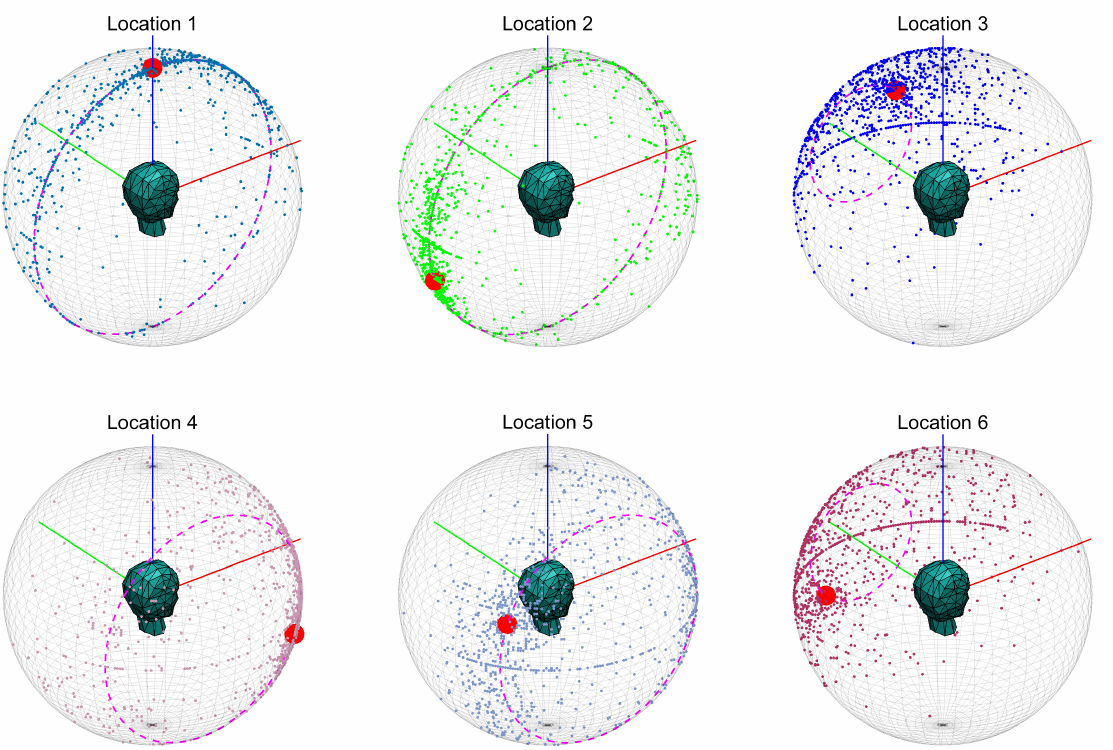
Figure 5. Distribution of the acoustic pointer direction recorded during the listening test corresponding to each target source direction. The red dots symbolize directions of the target sound sources. The dashed magenta circles represent the respective cones of confusion on the sphere. The axes denote directions relative to the listener: red—front, green—left, blue—top.